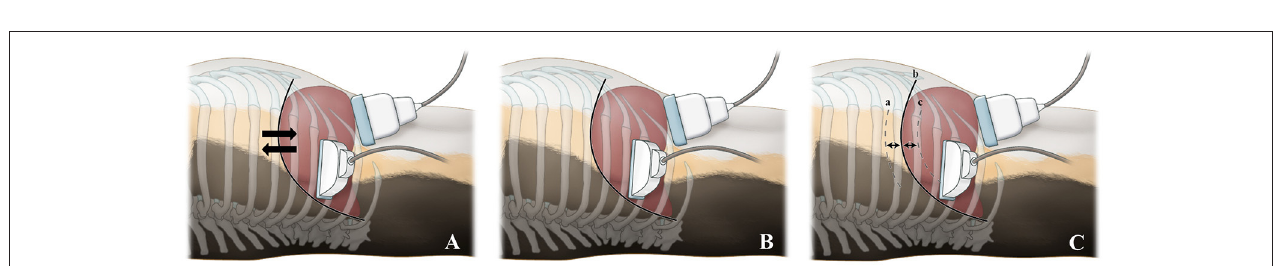
FIGURE 2 | Illustration of diaphragmatic and hepatic movements in various breathing conditions and probe positions according to the scanning approaches. During both the conscious and anesthetized free-breathing conditions (A), the diaphragm and liver move freely during spontaneous breathing. During the conscious breath-holding condition (B) , the diaphragm and liver do not move and are temporarily held in a static position, as breathing is halted by holding the nose and mouth or by blowing air into the nose. During the anesthetized breath-holding condition (C) , the diaphragm and liver do not move and are held in a static position. The diaphragmatic positions are illustrated in forced-expiration (cranial; 5 and 10 mL/kg) (a), end-expiration (neutral; 0cm H 2 O) (b), and forced-inspiration (caudal; 5, 10, 15, and 20cm H 2 O) (c). For the intercostal approach, the probe was placed parallel to the ribs in the 10–12th intercostal space. For the subcostal approach, the probe was positioned beneath the costal arch.